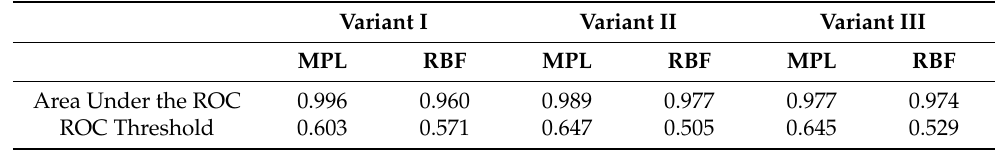
Table 4. Area under the ROC curves and ROC